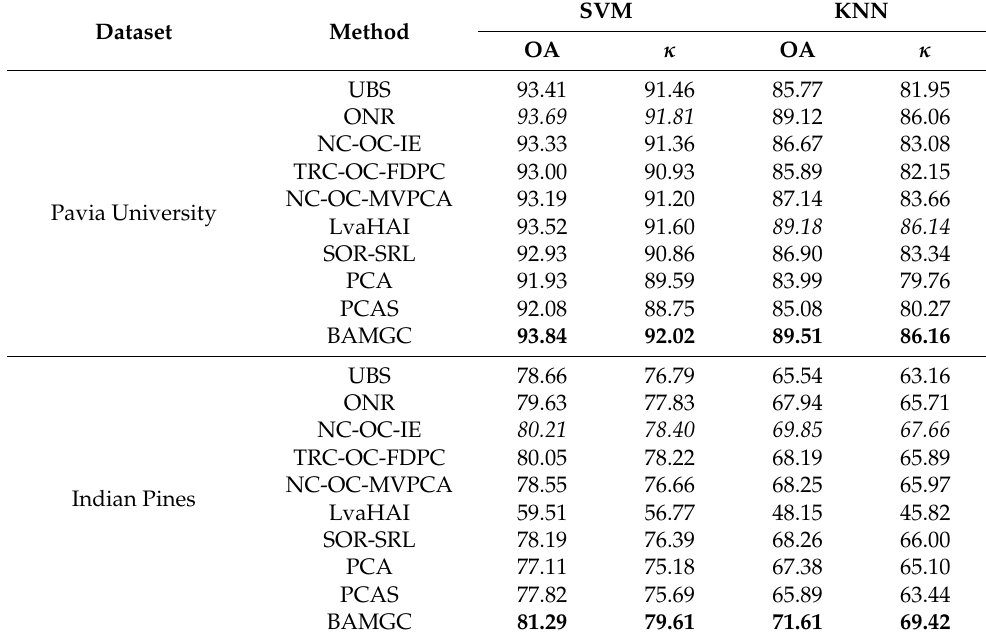
Table 4. Optimal results of each method in 30